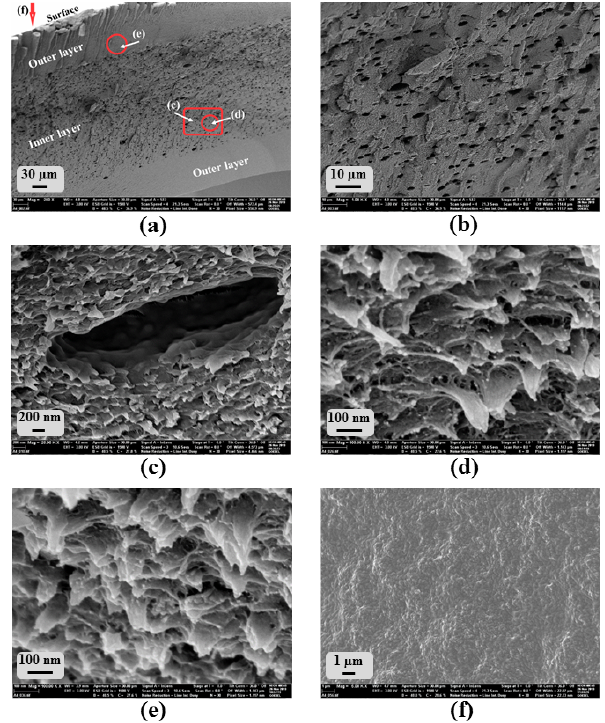
Figure 2. SEM images of several spots of porous PNIPAAm 2: overview of (a) the fracture surface and (b) the inner part of the fracture surface in (a) ; (c–e) close-ups; see (a) ; (f) surface of the hydrogel